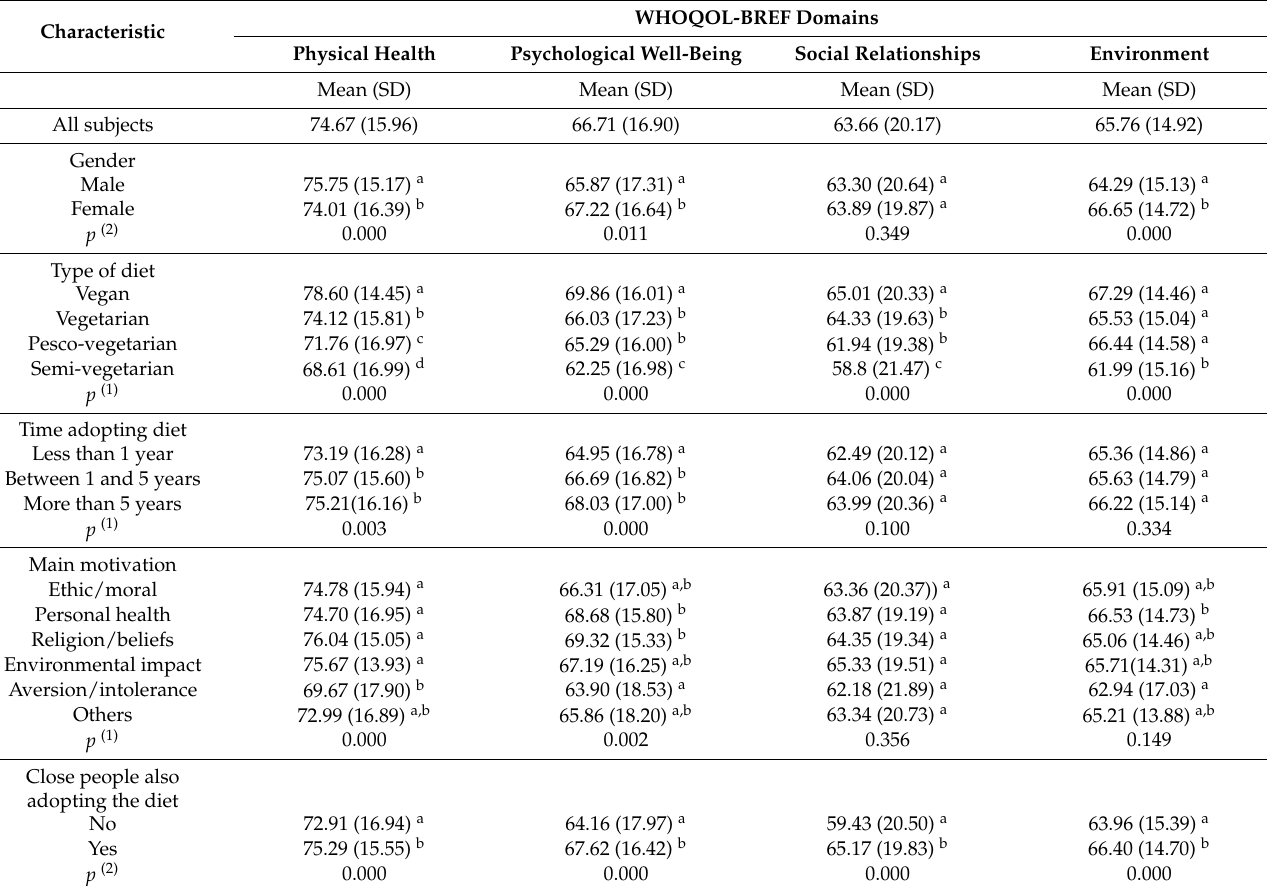
Table 2. Mean and standard deviation (SD) for WHOQOL-BREF domains, according to the sample characteristics. Characteristic